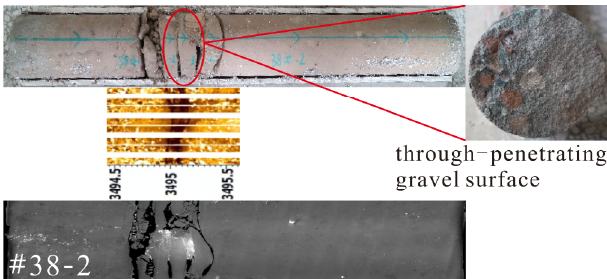
Figure 3. Features of a tensile fracture.